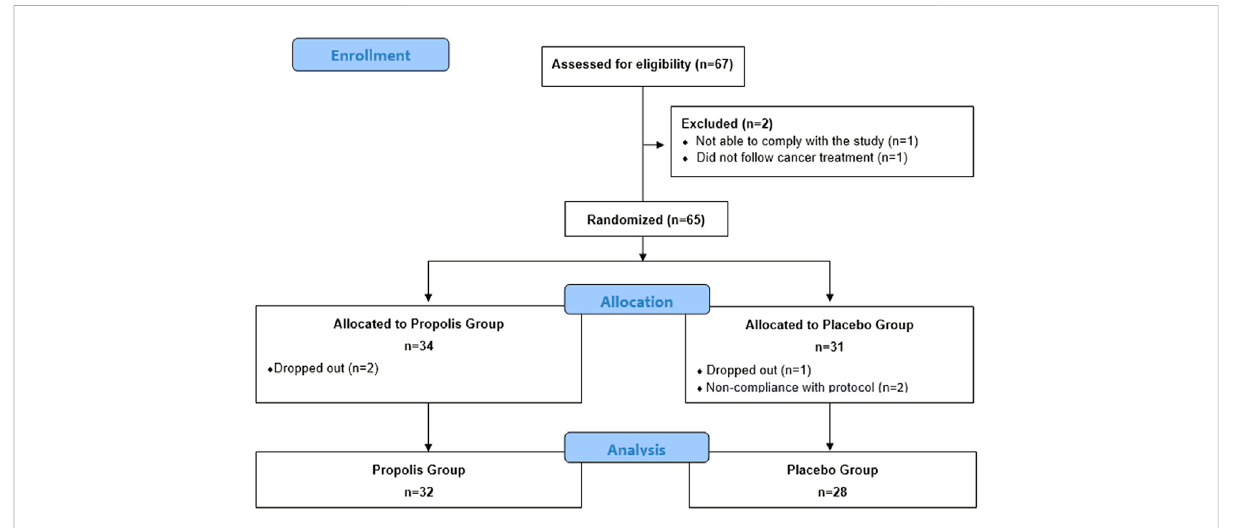
FIGURE 1 Consort 2010 fl ow diagram showing the recruitment of